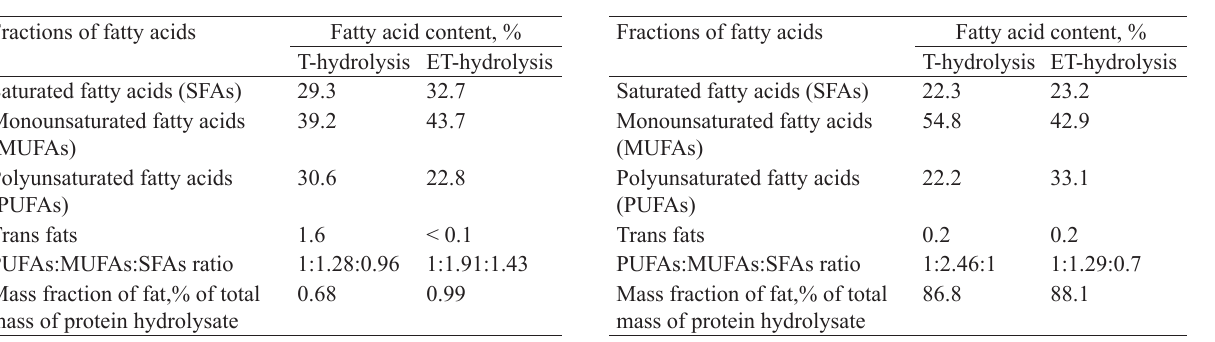
Table 6 Fractional composition of fatty acids in fat from sockeye heads after thermal and enzymatic-thermal hydrolysis